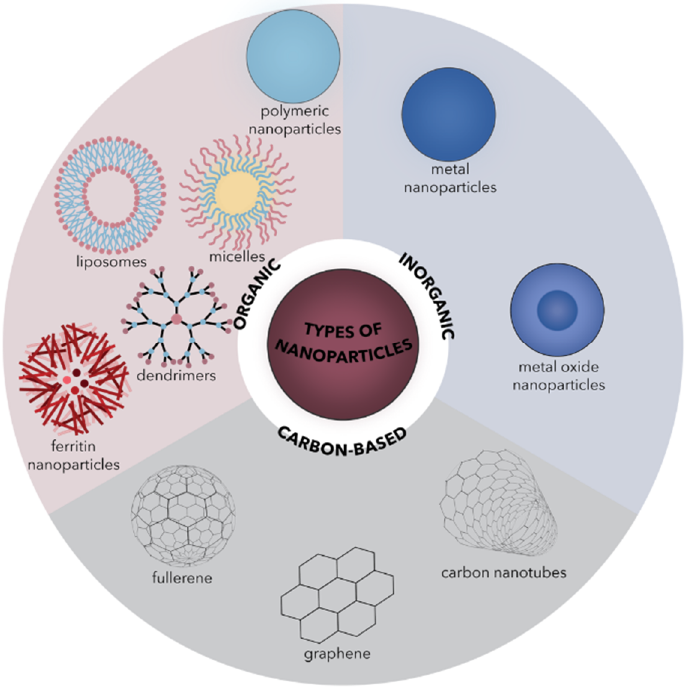
Figure 1. Schematic representation of the main types of NPs classified into organic, inorganic, and carbon-based NPs.